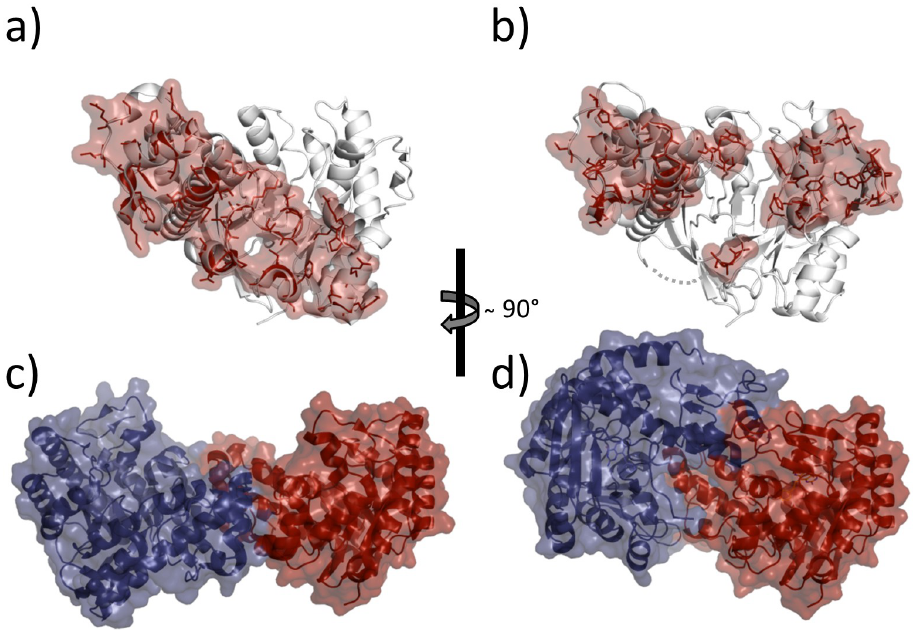
Fig 5. Comparison of alternative TGT dimer interfaces and oligomeric states. Dimer interface areas calculatedusing PDBePISA49are highlightedby red surface patches and stick representation. a) apo-TGT dimer interface area of monomer1: 1619 Å 2 (PDB entry: 1P0D [18]). b) twisted dimer interface of monomer 1: 1644 Å 2 (found in TGT (cid:1) 9 co ) c) oligomericstate of apo-TGT dimer (monomer 1 red, monomer 2 blue) d) oligomeric state of twisted dimer (monomer1 red, monomer2 blue).